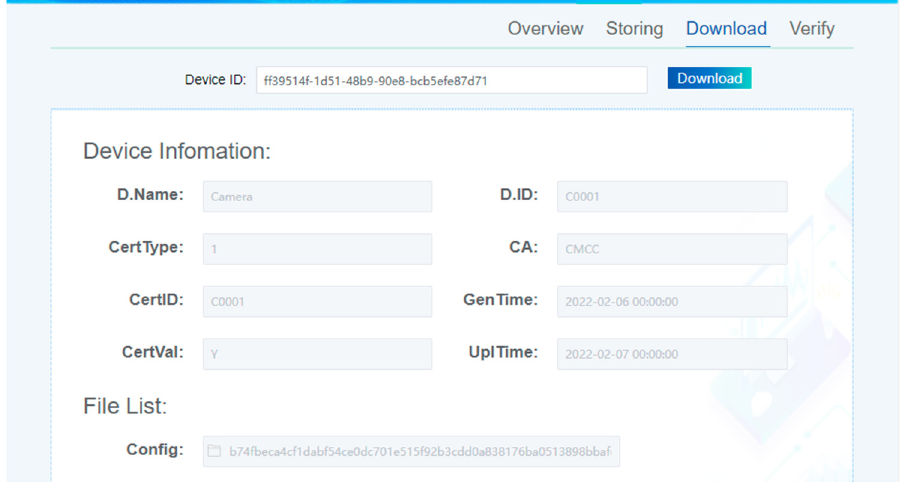
Figure 11. The process of downloading certificates and key information from the chain.